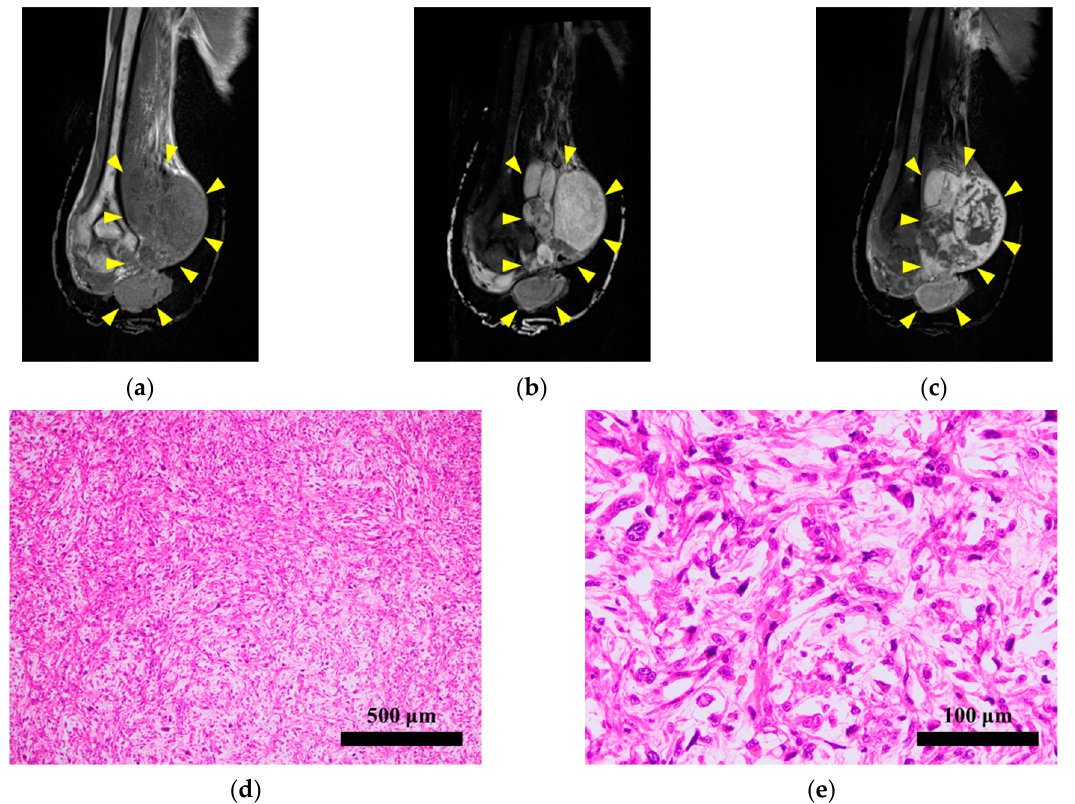
Figure 1. Clinical and pathological findings. Magnetic resonance imaging demonstrating a ( a ) low- intensity T1-weighted image and a ( b ) high-intensity STIR image of a soft tissue tumor around the right elbow, with a diameter of approximately 16 cm. ( c ) The periphery of the tumor was well enhanced by gadolinium. Yellow arrows indicate the tumor. ( d , e ) The tumor consisted of pleomorphic spindle cells with myxoid stroma and curvilinear vasculature.